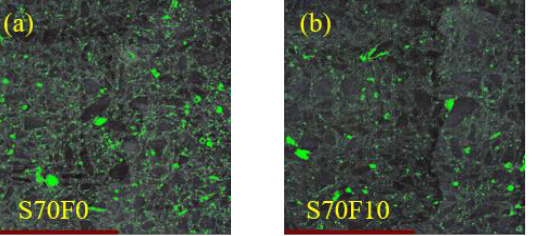
Figure 11. Distribution and proportion of the pore sizes of specimens ( a ) S70F0; ( b ) S70F10; ( c ) S75F0; ( d )